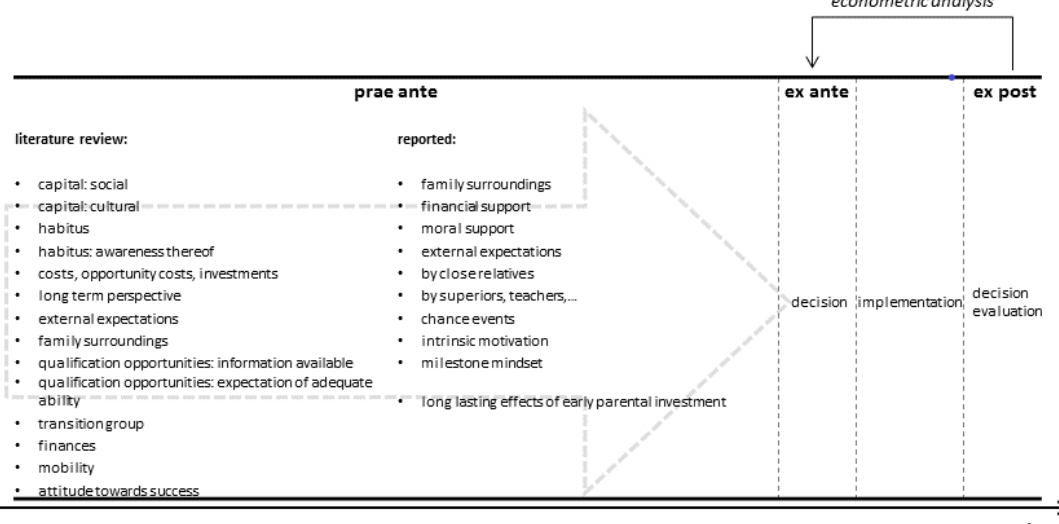
Figure 2. Factors informing the prae ante view. 427